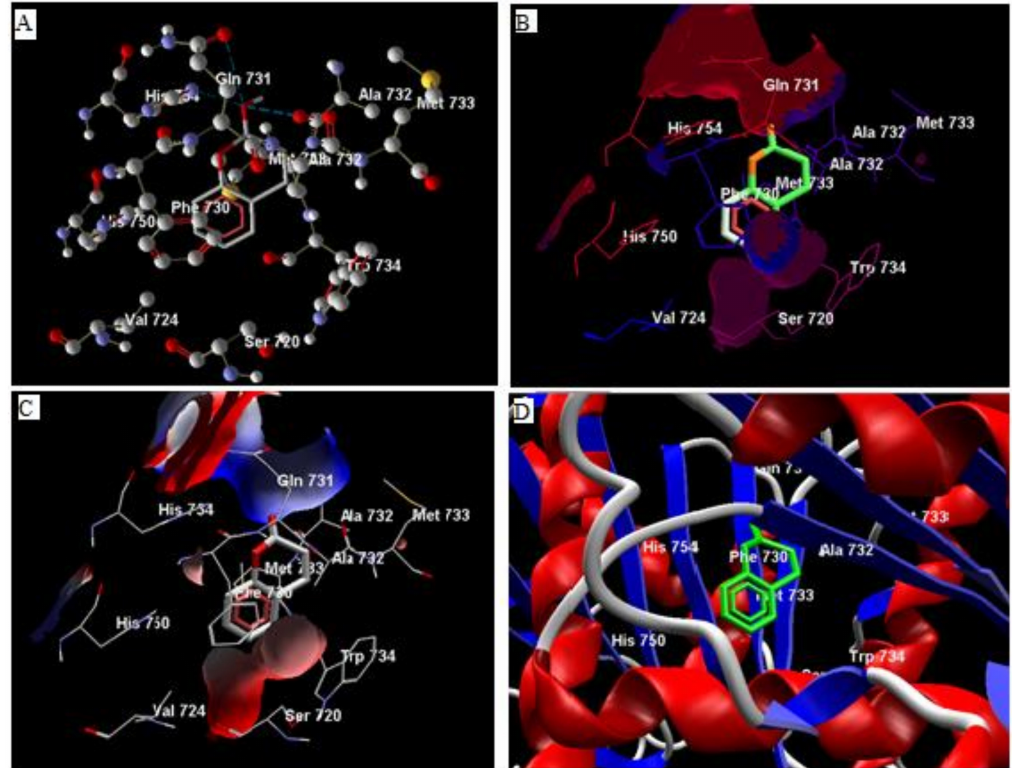
Figure 3. The hydrogen bonds ( A ), hydrophobic binding ( B ), electrostatic binding ( C ), and secondary protein interaction ( D ) of coumarin and dipeptidyl peptidase-IV